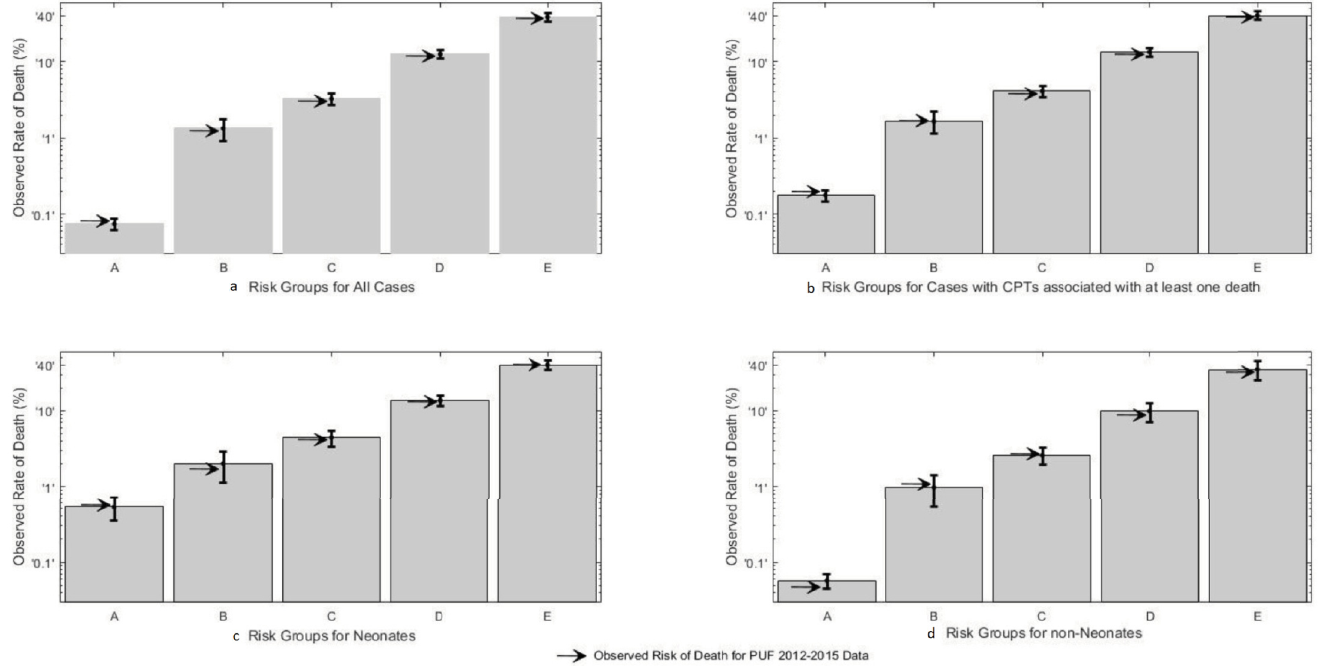
Fig 1. Observed mortality by risk group for sub groups. The observed mortality is plotted logarithmically by group. A = Very Low, B = Moderately Low, C = Moderately High, D = High, E = Very High. Each bar represents the estimate of the risk and confidence interval. The arrow is the observed rate for all patients from